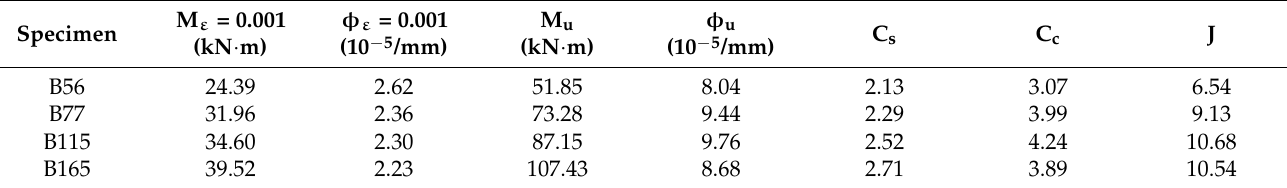
Table 6. Calculation results of deformability